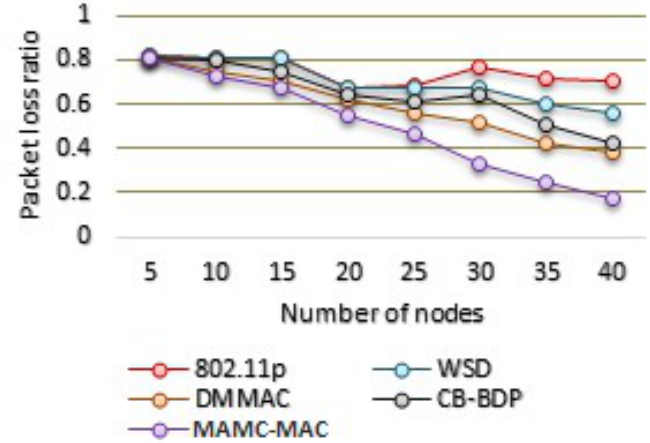
Figure 8. Packet loss ratio